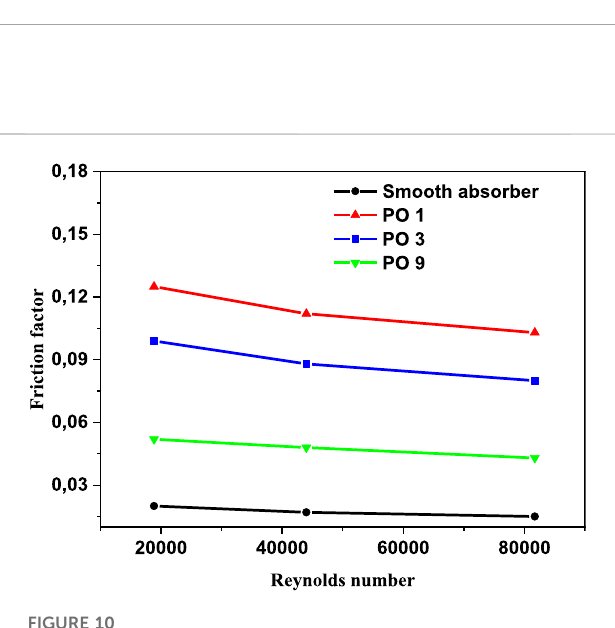
FIGURE 9 Nu variation in the absorber vs. Reynolds number (P/D = 2).